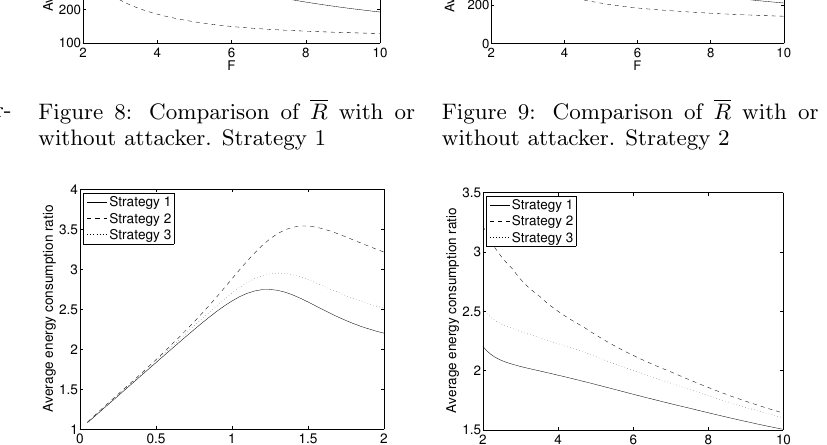
Figure 11: Ratio between values of R with and without attacker, F ∈ (0 , 2]